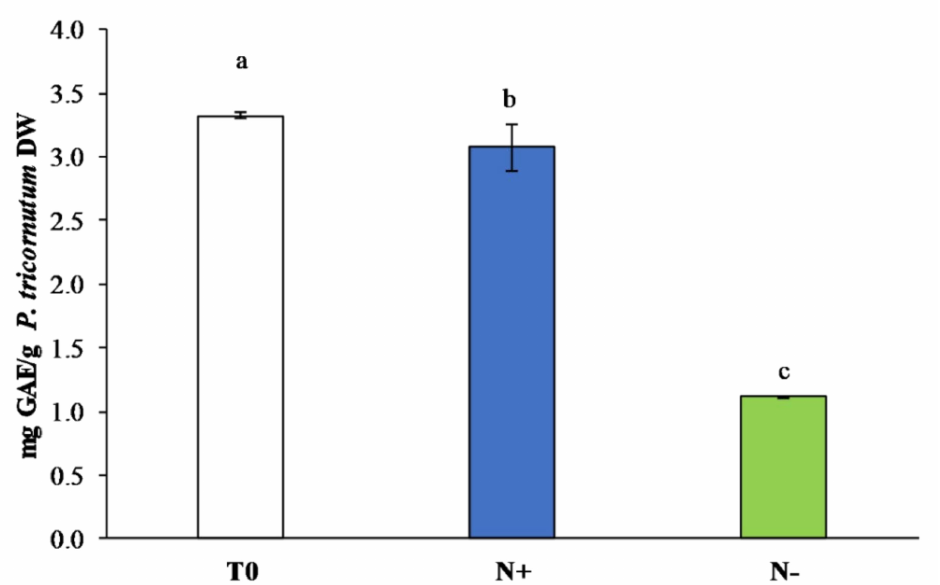
Figure 5. Total polyphenol content (mg GAE/g DW) in P. tricornutum extracts cultivated for 15 days under initial culture conditions (T0, white bar), under standard conditions (N+, blue bar), and under starvation conditions (N − , green bar). Values are reported as the means ( n = 3), and error bars report the standard deviations. Treatments that do not share the same letter were significantly different from each other ( p <